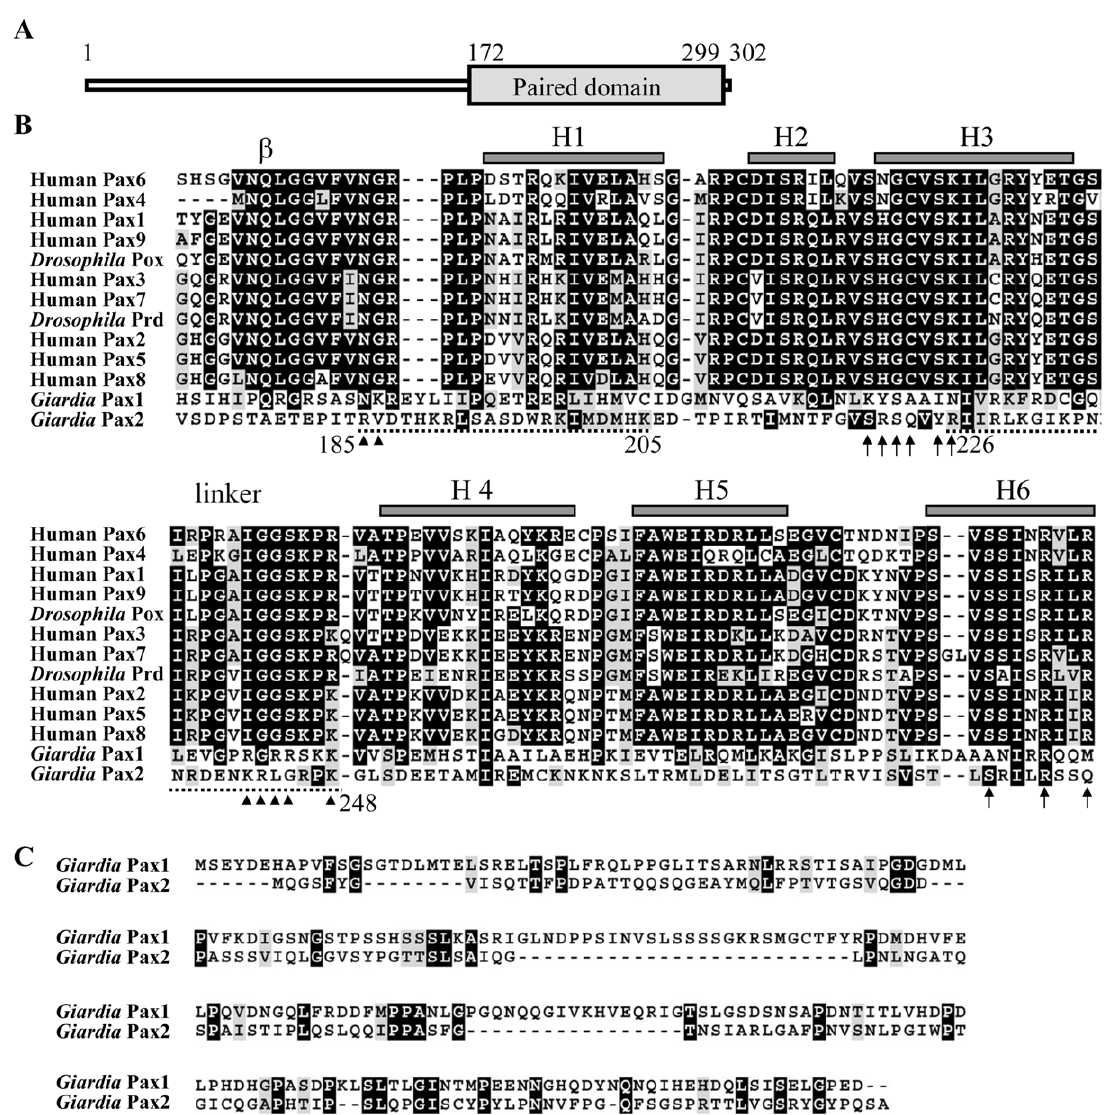
Figure 1. Domain architecture of Pax2 protein and alignment of the paired domains. (A) Schematic representation of the giardial Pax2 protein. The gray boxes indicate the paired domains. (B) Alignment of the paired domains. The paired domains from members of the human and Drosophila Pax family are analyzed by ClustalW 1.83 [80]. GenBank accession numbers for human Pax1 to 9 and Drosophila Prd are NM_006192, NM_000278, NM_181458, NM_006193, NM_016734, NM_000280, NM_001135254, NM_003466, NM_006194, and NM_164990, respectively. The open reading frame numbers (GenBank accession numbers) for the giardial Pax1 and Pax2 are 32686 (XM_001704983.1) and 16640 (XM_001709076.1) in the G. lamblia genome data base, respectively. Letters in black boxes, letters in gray boxes, and hyphens indicate identical amino acids, similar amino acids and gaps in the respective proteins, respectively. Gray boxes indicate the a helices in the paired domain of human Pax6 [58]. The arrows indicate the key residues contacting the major groove in human Pax6 or Drosophila Prd [58], [62]. The arrowheads indicate the residues that make contact with the minor groove/phosphodiester backbone in human Pax6 or Drosophila Prd [58], [62]. Two regions (residues 185–205 and 226–248) rich in basic amino acid residues are underlined by dotted lines. (C) Alignment of N-terminal regions of giardial Pax2 and Pax1 ClustalW 1.83 [80]. Letters in black boxes, letters in gray boxes, and hyphens indicate identical amino acids, similar amino acids and gaps in the respective proteins,